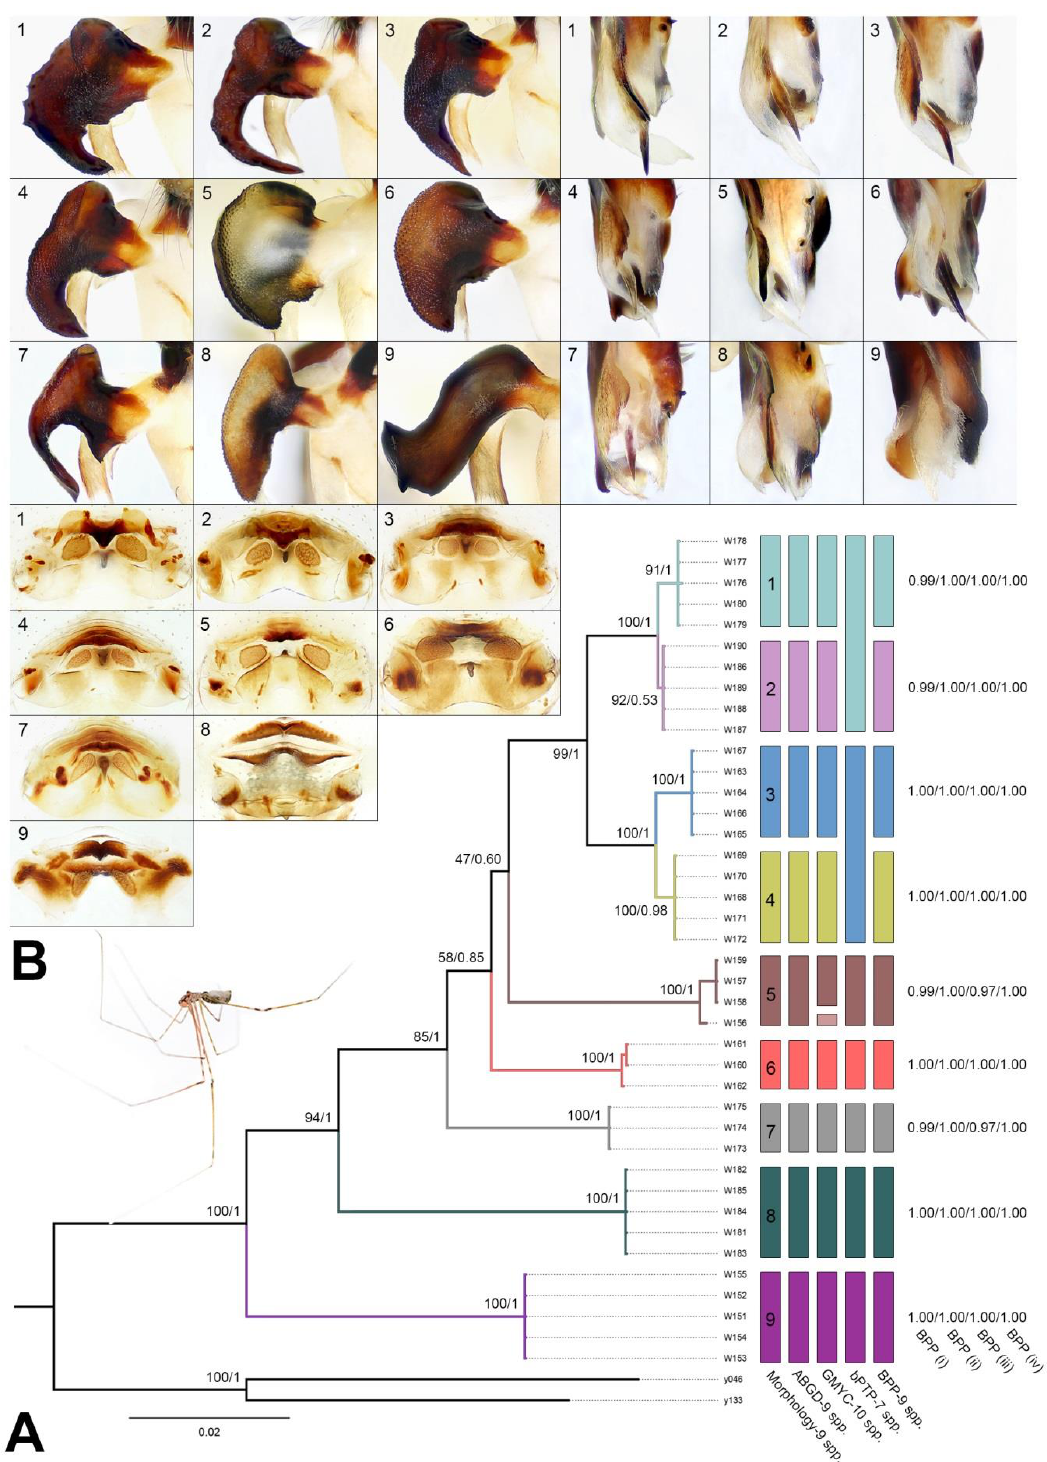
Figure 2. The results of species delimitation analyses: ( A ) Phylogenetic tree inferred from BI analysis, boostrap values/Bayesian posterior probabilities are provided at the nodes (species delimitation methods and posterior probabilities from BPP are presented on the right, different colors of the bars represent the different species); ( B ) Uncus, distal part of procursus, and vulva (more details are provided under the Taxonomic accounts, see below). 1: P . wenshui sp. nov.; 2: P . jiaocheng sp. nov.; 3: P . luliang sp. nov.; 4: P . zhongyang sp. nov.; 5: P . linfen sp. nov.; 6: P . xiangfen sp. nov.; 7: P . lishi sp. nov.; 8: P . xuanzhong sp. nov.; 9: P . luya